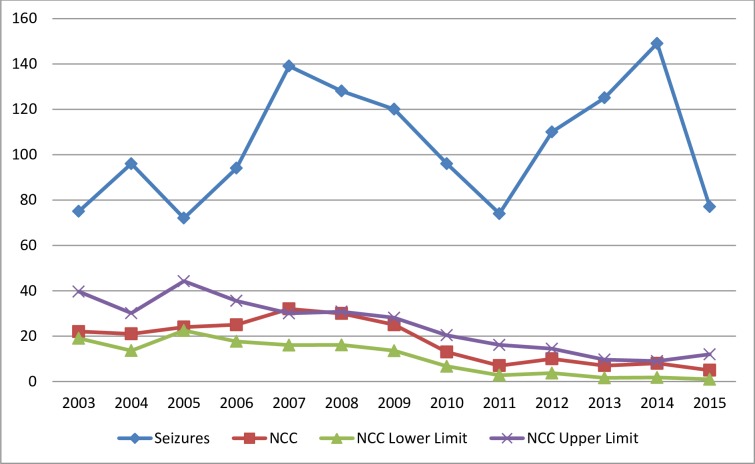
Distribution of NCC cases per year.